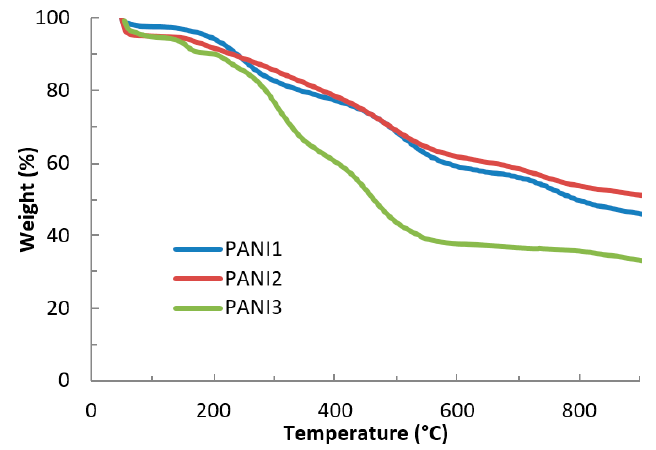
Figure 5. TGA curves of PANI1, PANI2 and PANI3.